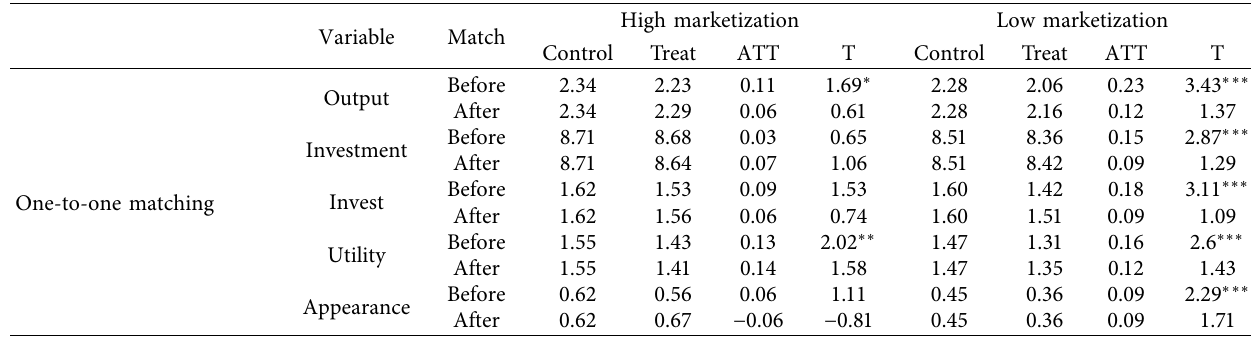
Table 6: Policy incentive effects under different degrees of marketization.